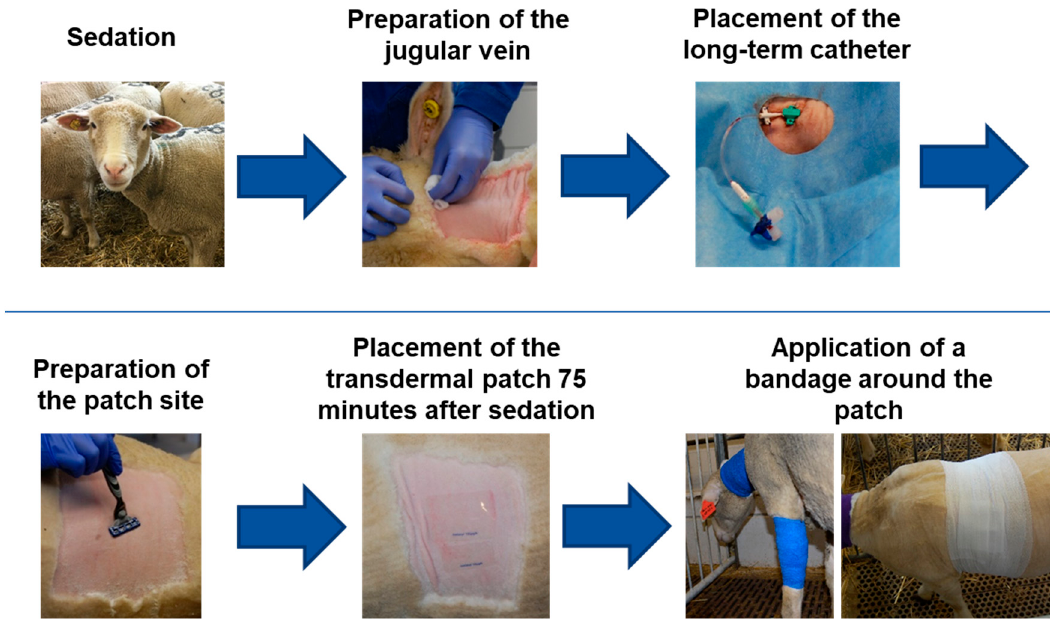
Figure 3. Work flow of the long-term catheter placement and transdermal fentanyl patch application.